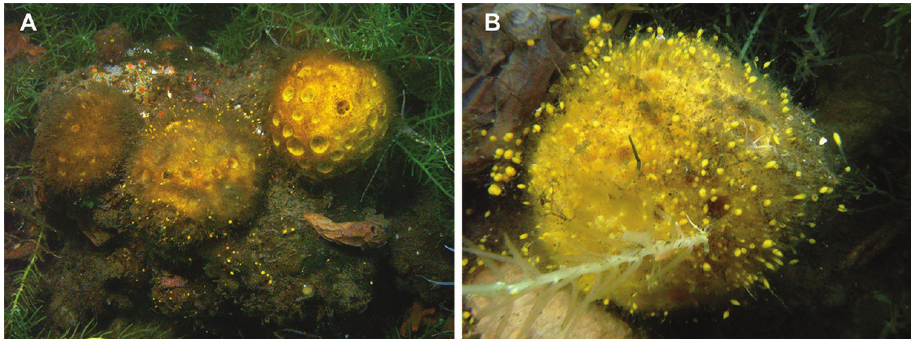
Figure 8. Budding and sediment capture of Cinachyrella species A Three individuals of C. porosa in Haji Buang lake, East Kalimantan, Indonesia, showing distribution of buds beyond the individuals and sediment capture B Close up of C. porosa with detail of buds. Each individual is approximately 4 cm in